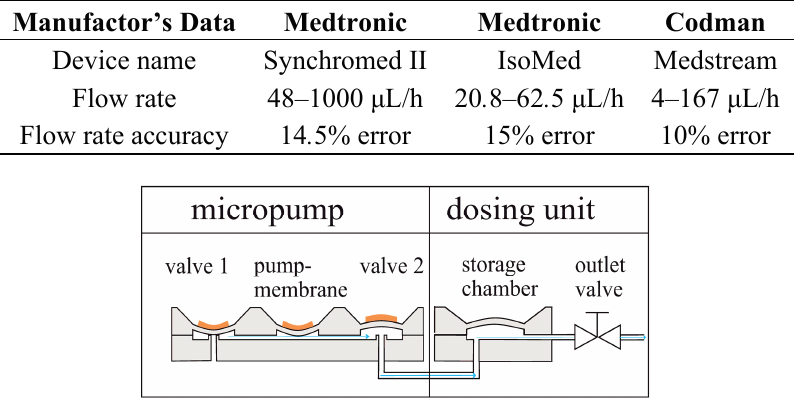
Figure 1. Working principle of the drug delivery system. The storage chamber is filled by the micro-pump. During the filling procedure the outlet valve is closed. The membrane, which caps the storage chamber, bends due to the increased pressure. The outlet valve can be opened on demand, so that the bended membrane